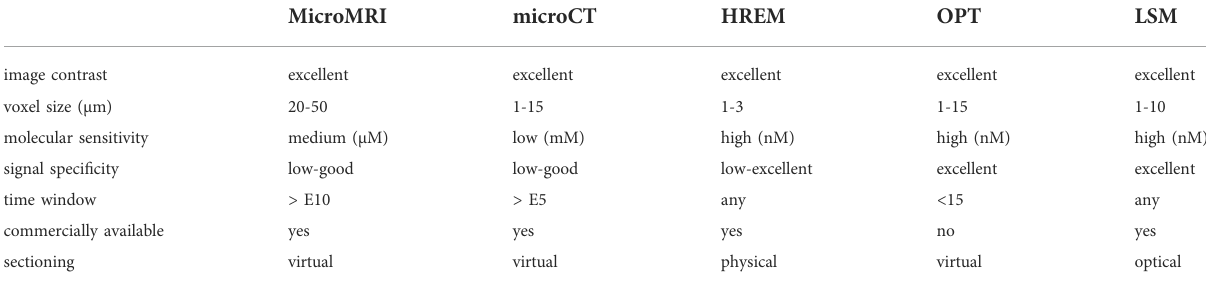
TABLE 2 Comparison of contemporary ex vivo 3D microscopy modalities for mouse embryo